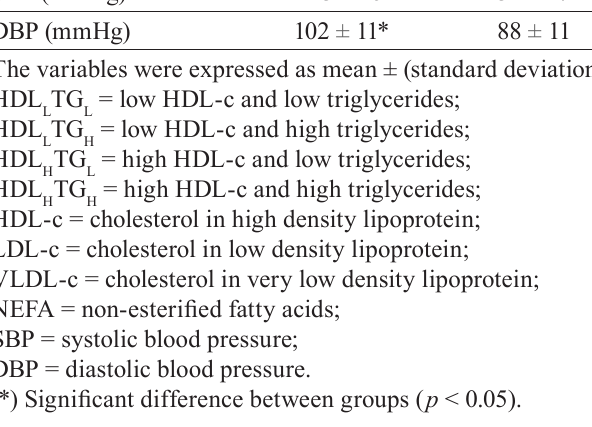
LDL-c = cholesterol in low density lipoprotein; VLDL-c = cholesterol in very low density lipoprotein; NEFA = non-esterified fatty